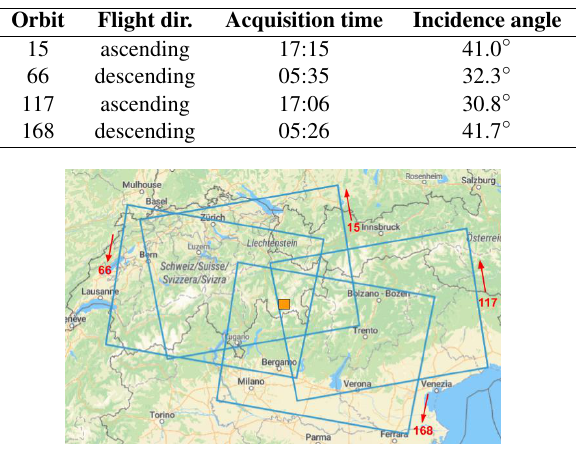
Table 3: Details of four orbits scanning Region Sils such as orbit number, flight direction, acquisition time in Universal Coordin- ate Time (UTC), and approximate incidence angle.